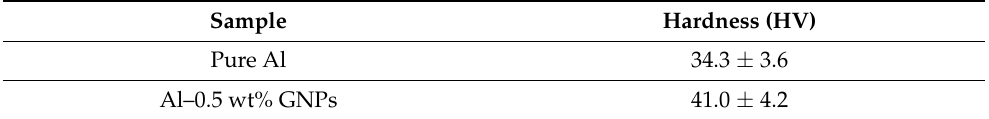
Table 3. Hardness test results of pure Al and Al–0.5 wt% GNP